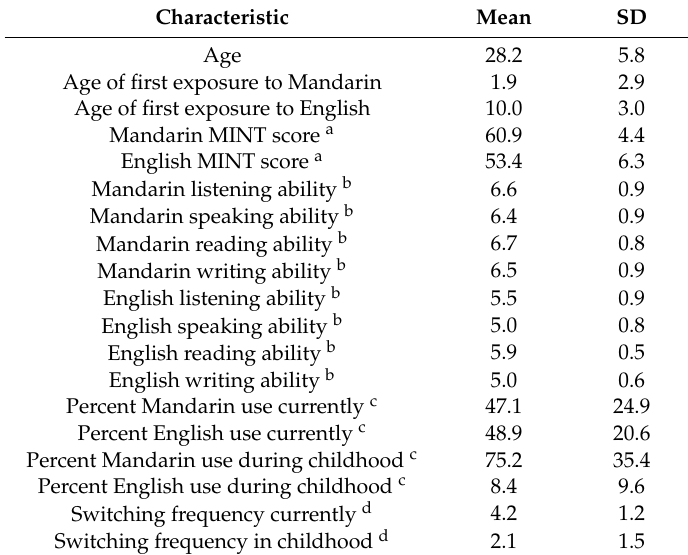
Table 1. Characteristics of included participants in Experiment